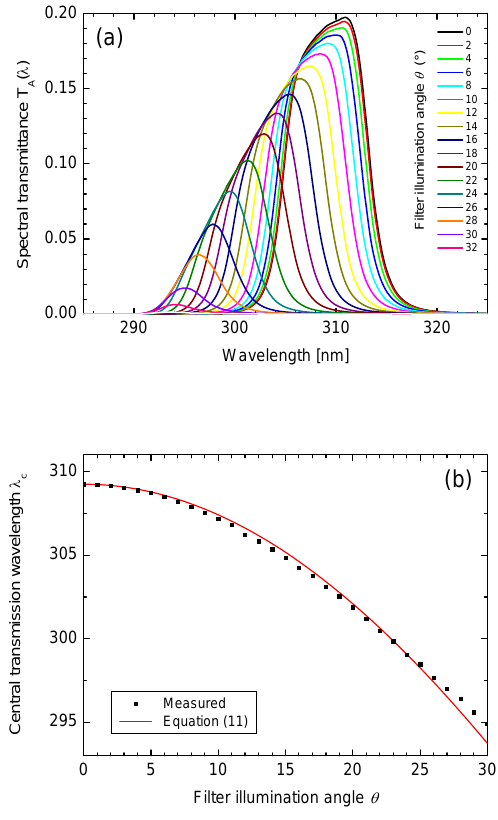
Fig. 5. (a) Measured relative filter transmittance T A ( λ ) as a func- tion of the illumination angle θ . (b) Dots: measured central trans- mittance wavelength λ c of the interference filter as a function of filter illumination angle θ . Line: central transmittance wavelength according to Eq. (11) assuming a refractive index n of 1.6 (typi- cal value for quartz optics). The filter transmittance window shifts towards lower wavelengths if the filter is illuminated in a non- perpendicular direction (filter illumination angle θ ≠ 0).